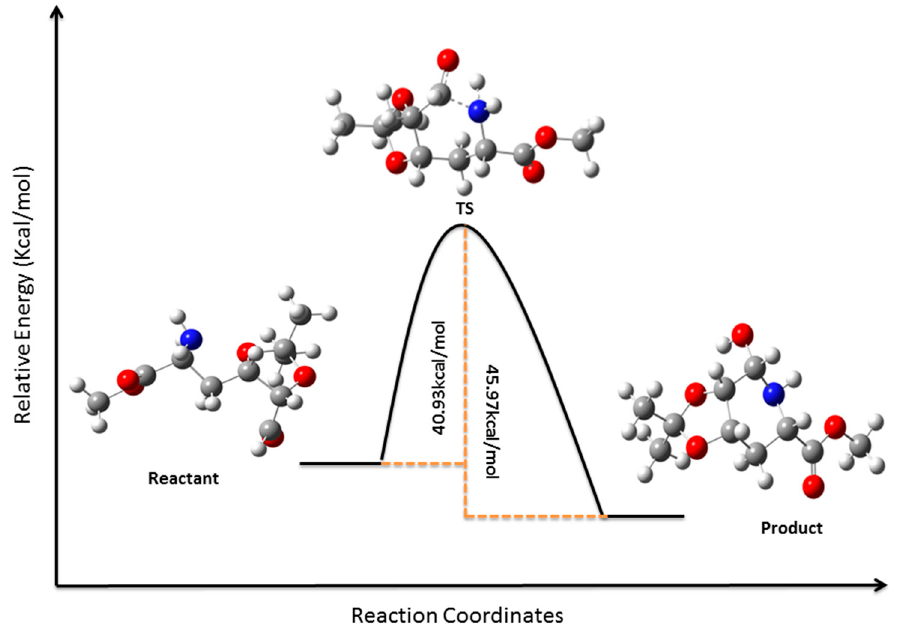
Figure 1. Minimum energy conformations, activation energy, and transition state for the intramolecular nucleophilic attack of amine on the aldehyde of intermediate 7a (reactant) to obtain 8 (product). (DFT, Gaussian 9.0)